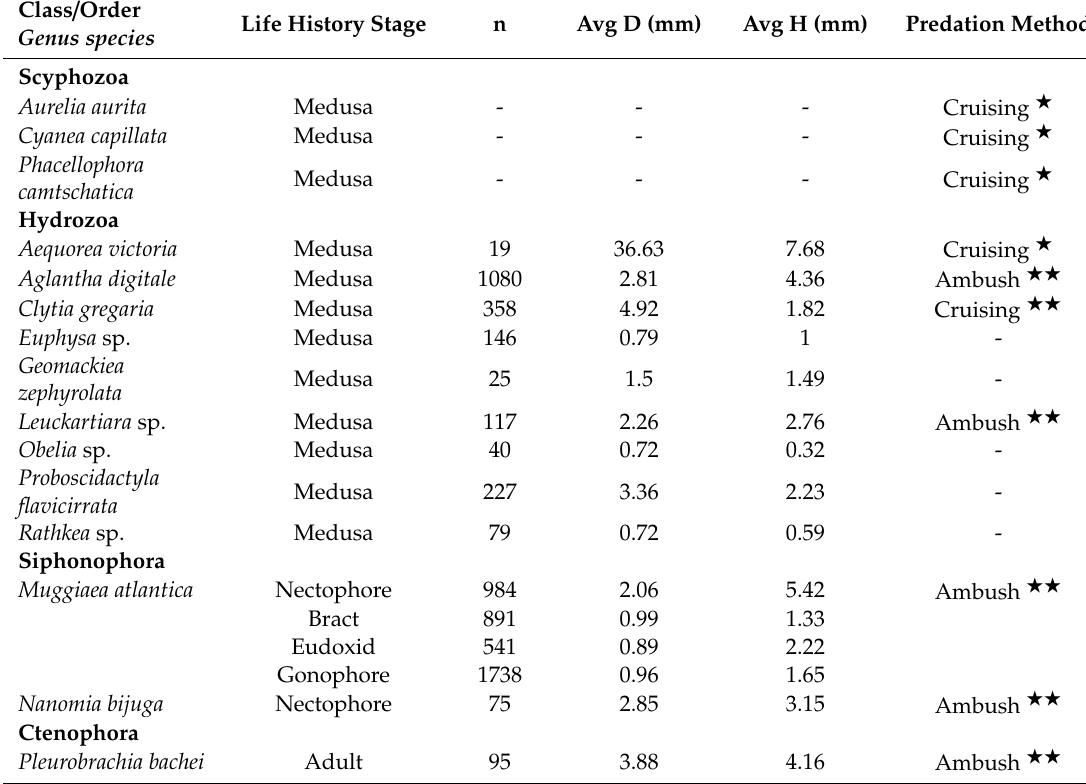
Table 1. Average diameter (D), bell height (H), number measured ( n ), and predation method of megaplankton and mesoplankton species collected from Hood Canal. Note only sizes of mesoplanktonic species are